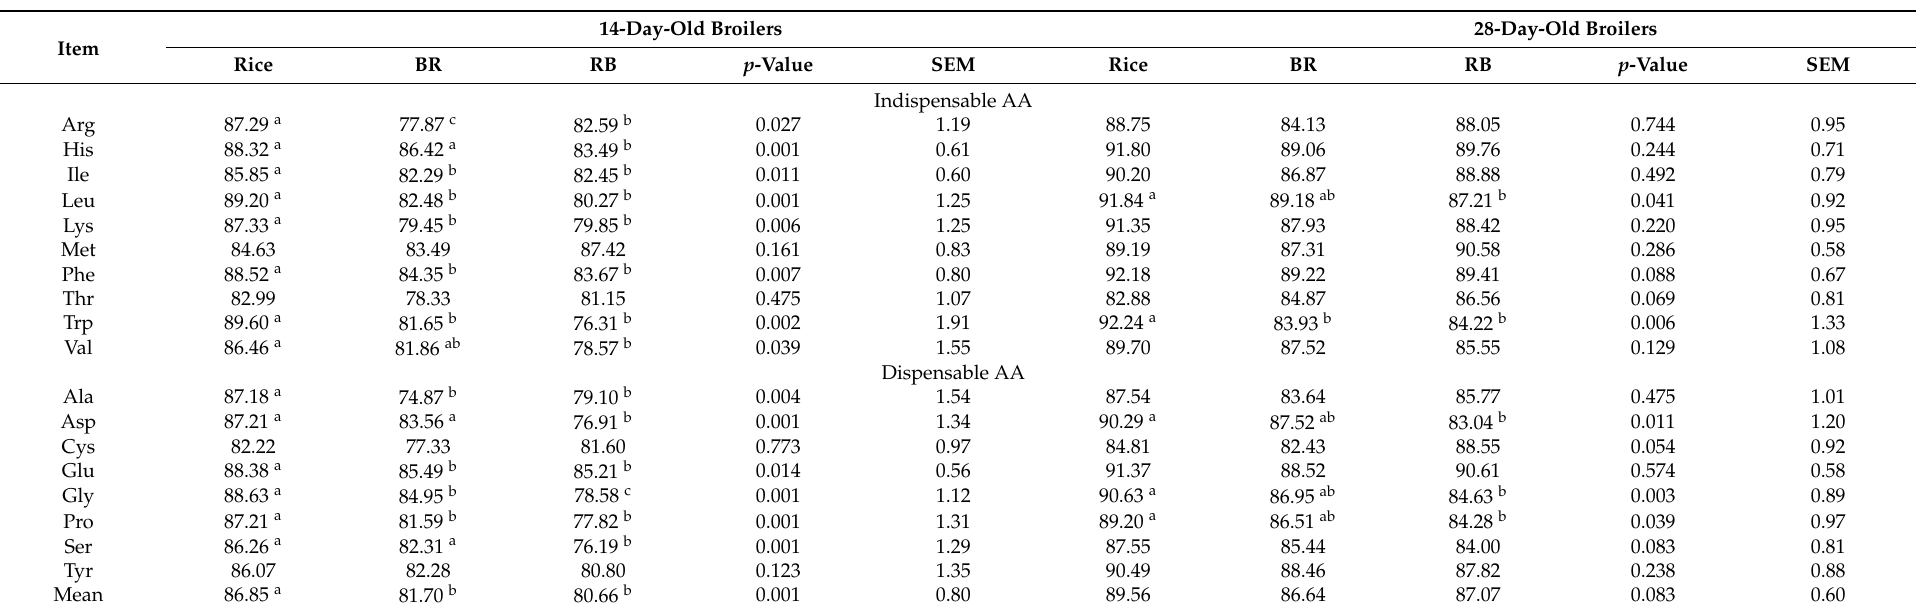
Table 10. Analyzed standardized amino acid digestibility (SIAAD) of experiment diets of broilers